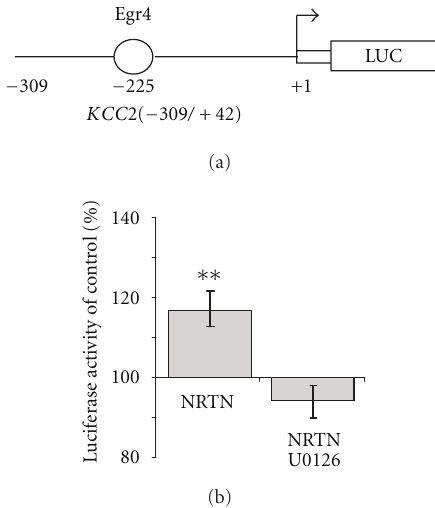
Figure 2: Neurturin-induced activation of KCC2 proximal pro- moter region. (a) Schematic drawing of the luciferase construct carrying the KCC2 proximal promoter region. The construct contains the luciferase reporter gene under control of a short (309bp) upstream proximal part of the KCC2 promoter sequence. (b) Normalized luciferase activity 2–4 hours after application of 50 ng/mL Neurturin in div7 hippocampal neuronal cultures transfected with the KCC2 ( − 309/+42) construct ( n = 4; ∗∗ P < 0 . 01). Error bars represent